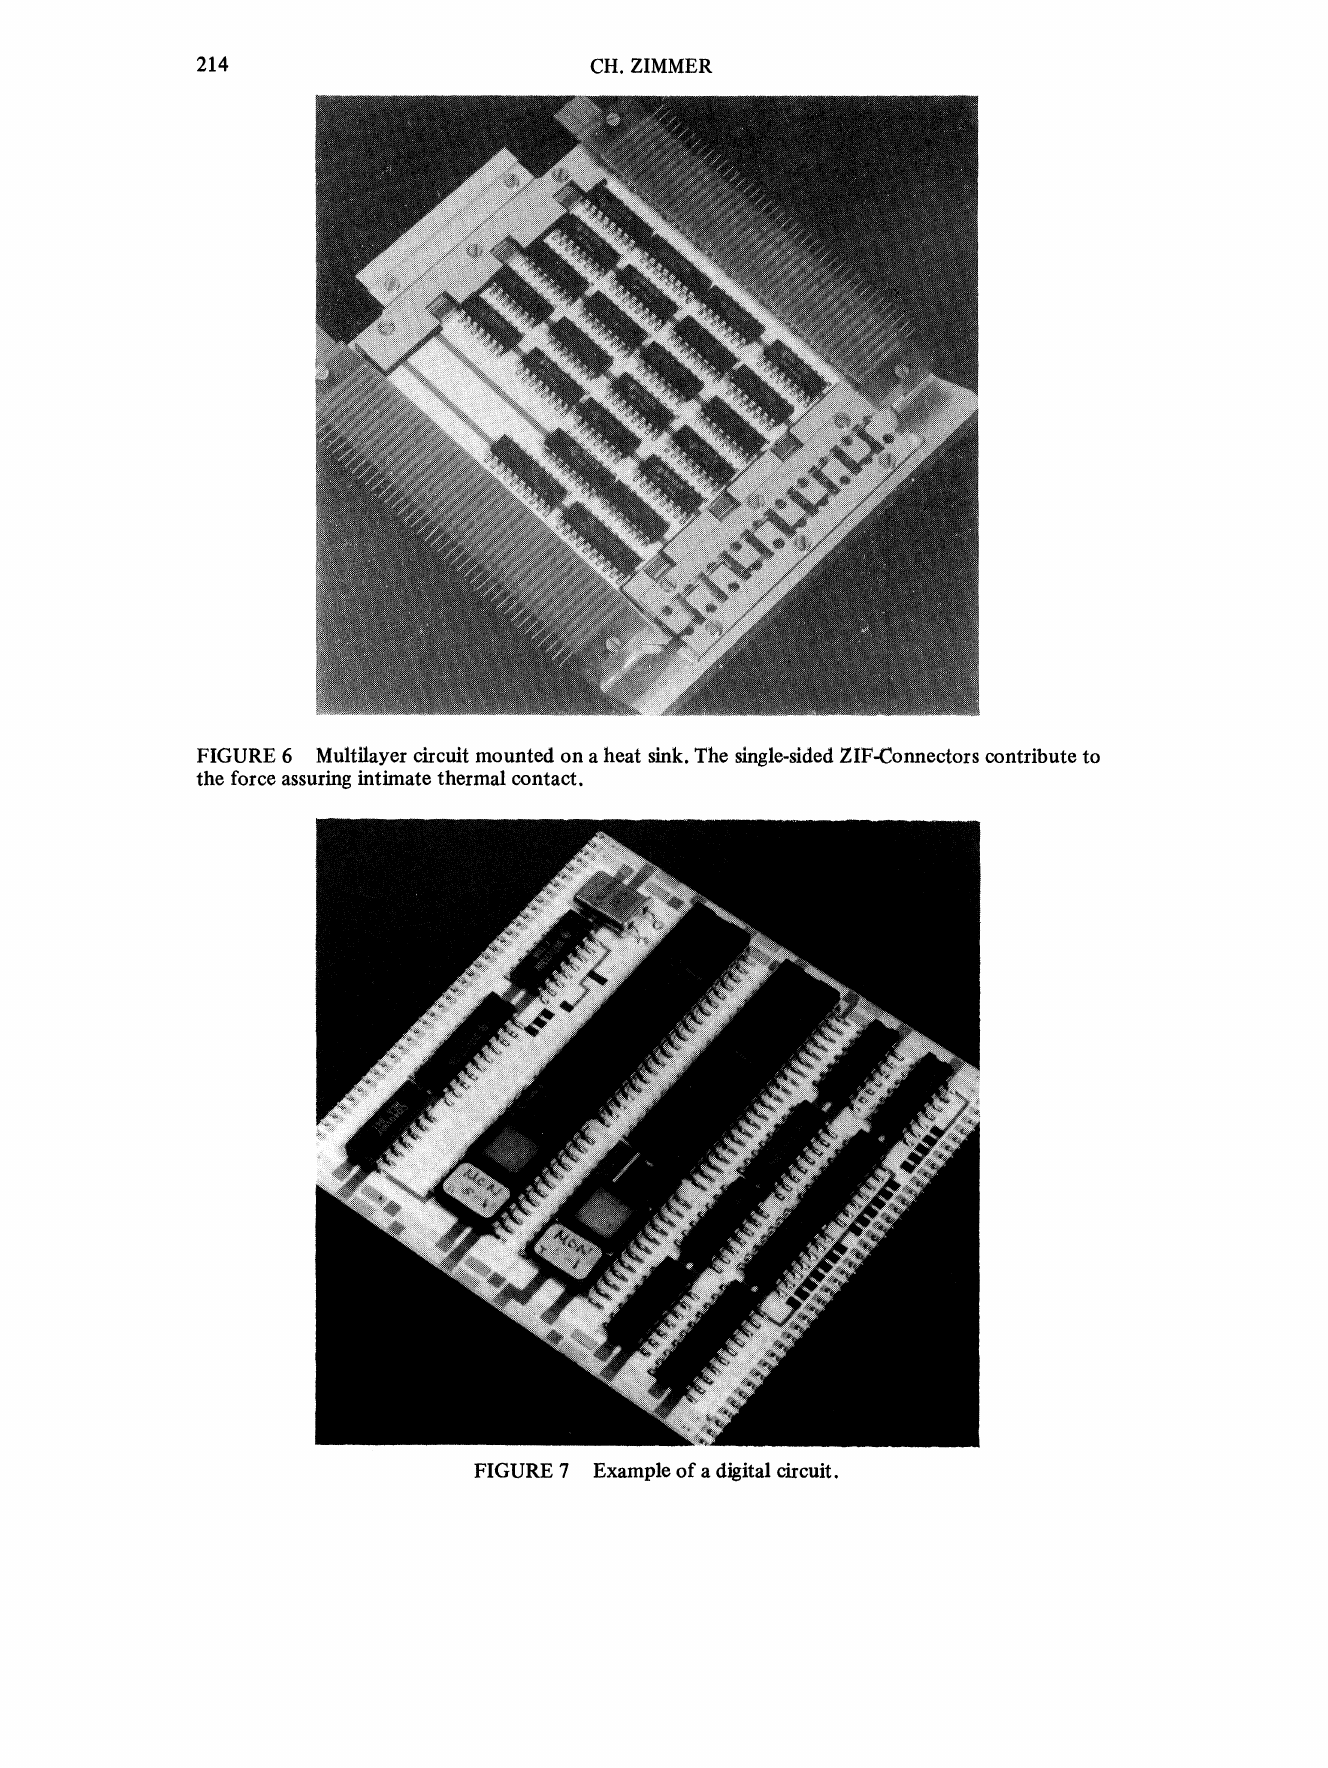
FIGURE 7 Example of a digital